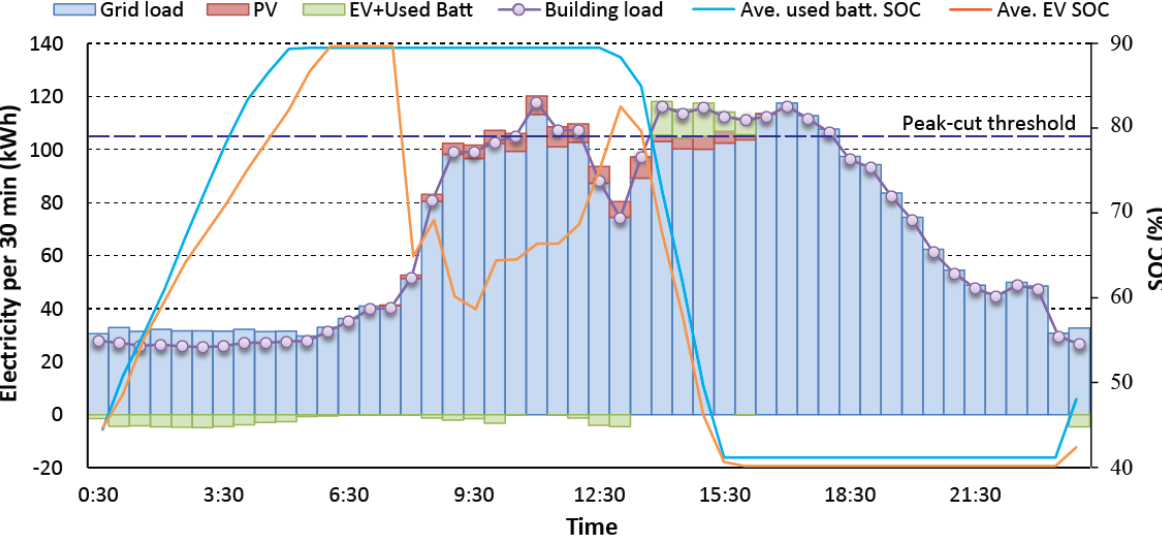
Figure 9. Load leveling test on a representative